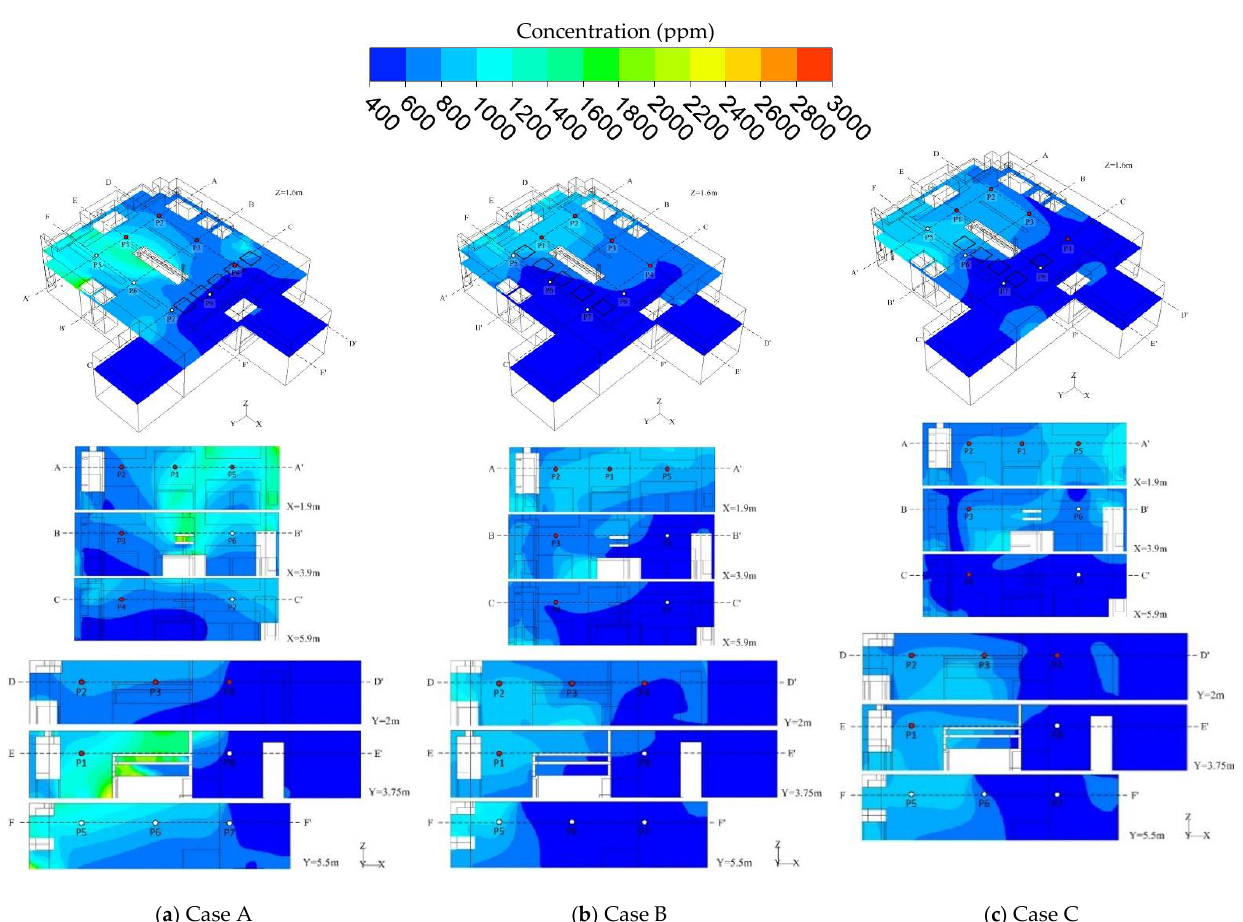
Figure 9. Concentration distribution results in different layout arrangements.